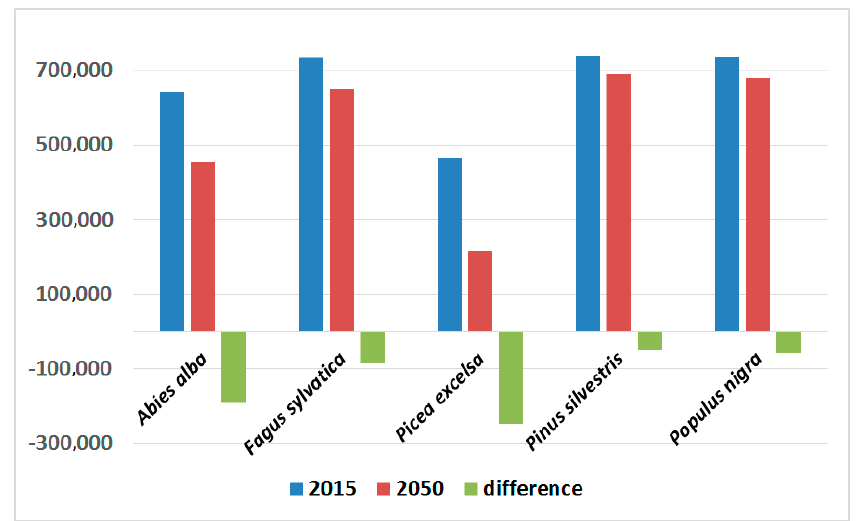
Figure 4. Amount of plots for the potential distribution of the suitable areas of the five tree species in 2015 and 2050. Table 2. Estimated amount of plots for suitable areas of the five tree species in 2015 and 2050 (diff = difference between 2050 and 2015; diff % is the percentage of this